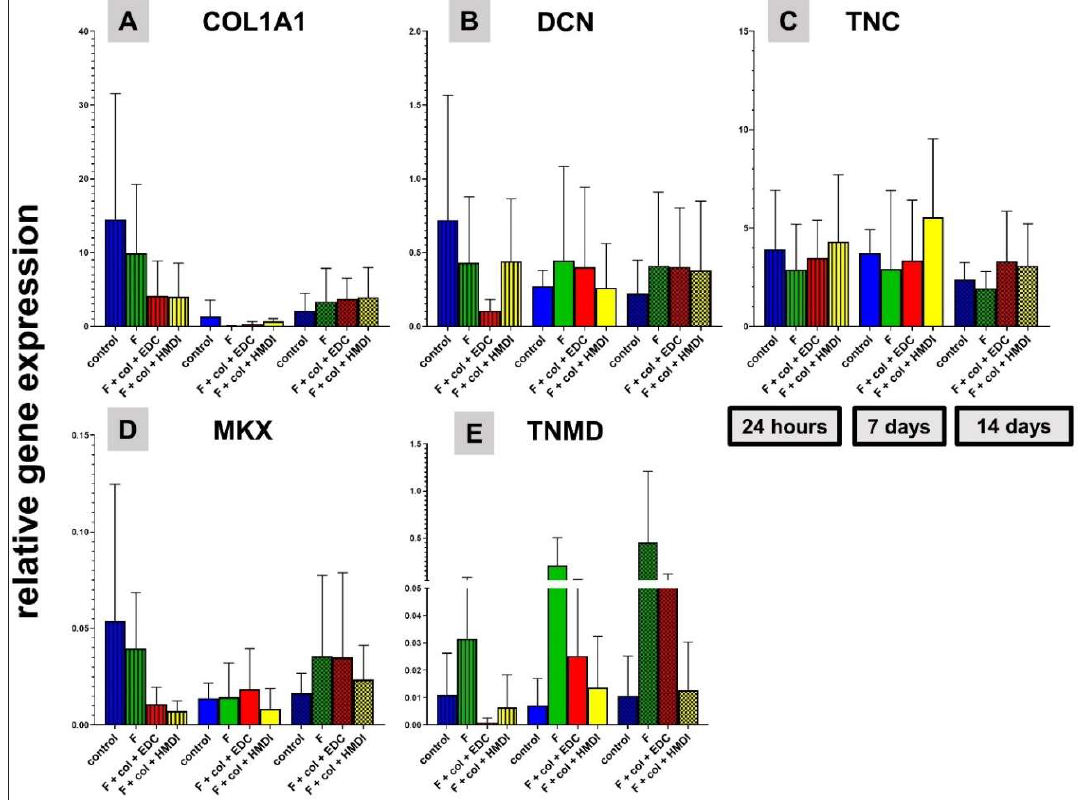
Figure 7. Expression level of genes for ligament extracellular matrix components and the transcription factor Mohawk (MKX) after 24 h, 7 days and 14 days in the di ff erent sca ff old functionalization variants. Relative gene expression of type I collagen (COL1A1, A ), of decorin (DCN, B ), of tenascin C (TNC, C ), Mohawk (MKX, D ) and tenomodulin (TNMD, E ). All diagrams summarize n = 5 independent experiments with cells of 5 di ff erent donors and show means with standard deviation. No significant di ff erence could be calculated. Gene expressions were normalized to the reference gene GAPDH. Col, collagen foam; F, fluorinated; EDC, ethylcarbodiimide cross-linked; HMDI, hexamethylene diisocyanate